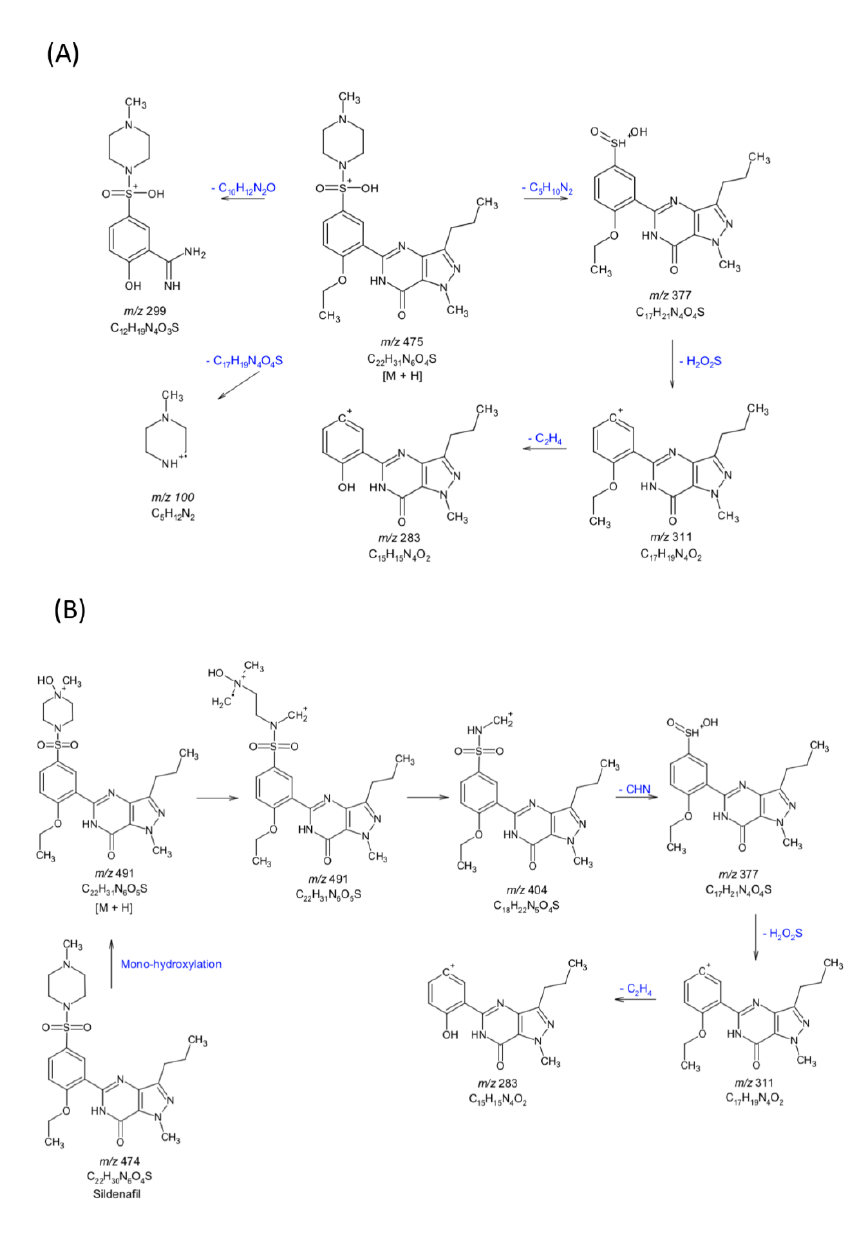
Figure 7. Proposed metabolic pathways of sildenafil citrate ( A ) and the sildenafil citrate microemulsion-loaded hydrogel (IPM system) ( B ) from the LC-MS/MS analysis.